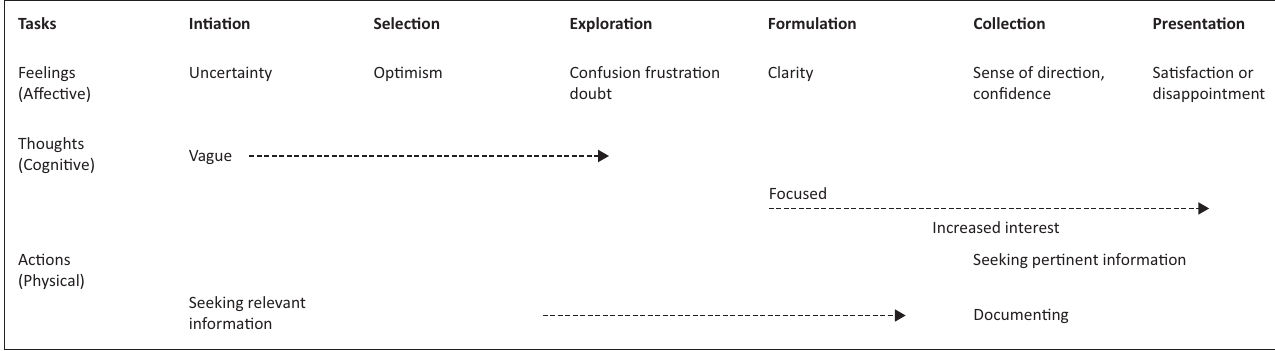
FIGURE 1: Summary of the information search process